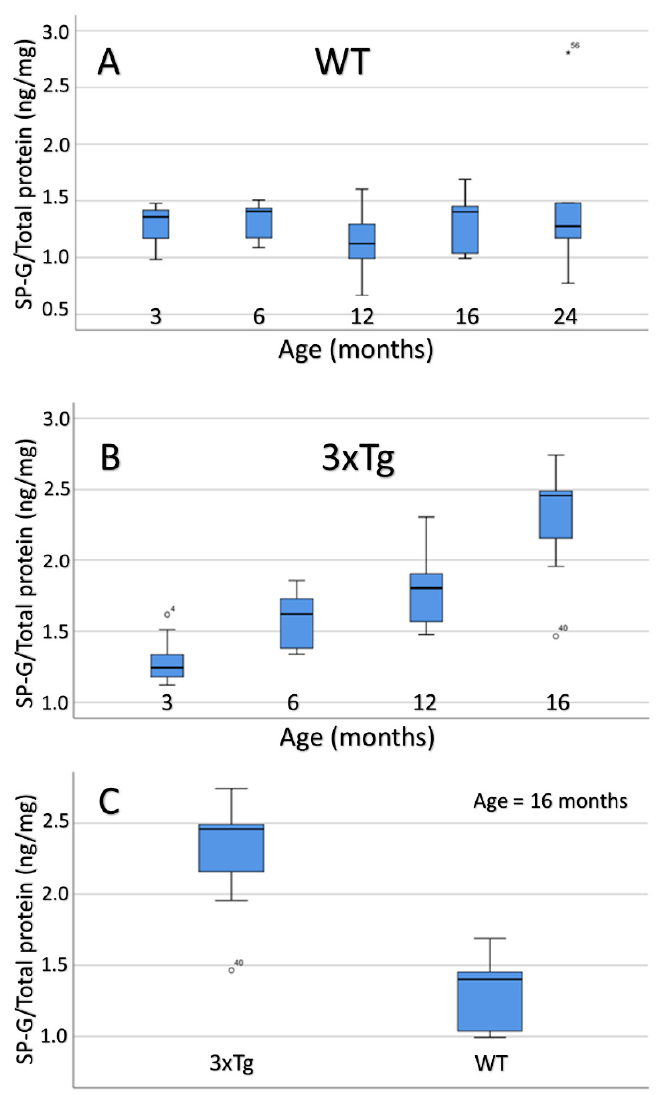
Figure 12. Box plot representation of the age-dependent SP-G content within the total intracellular brain protein fraction (specified in ng/mg). ( A ) WT mice: There are no statistically significant differences between the age groups. ( B ) In 3xTg mice, a clear increase of the SP-G content during aging becomes evident. The Tukey post-hoc analysis detected significant differences between all age groups except for the comparisons between 3 and 6 month-old animals ( p = 0.156) and 6 and 12 month-old mice ( p = 0.528). ( C ) Box plot representation of the SP-G content within the total intracellular protein fraction of 16 month-old mice brain depending on genotype (specified in ng/mg). ANOVA analysis revealed a significantly increased SP-G content in 3xTg mice when compared to their age-matched WT controls ( p = 0.001). ◦ : Indicates data values lying 1.5 to 3× of the IQR away from the mean value. *: Indicates data values lying >3× of the IQR away from the mean value. Comparing 3 month-old 3xTg mice with their age-matched controls showed no sig- The comparison of aging 3xTg-mice, however, shows a clear increase of intracellular nificant difference in intracellular SP-G content (ANOVA: p = 0.924). For the 6, 12, and 16 SP-G content (Figure 12B). The Tukey post-hoc analysis revealed a significant difference month-old animals, ANOVA analysis elucidated statistically significant greater contents between the 3 and 12 month-old 3xTg animals ( p = 0.005), as well as between the 3 and of intracellular SP-G in 3xTg mice than in age-matched WT mice (6 months: p = 0.023; 12 16 month-old mice ( p < 0.001). Furthermore, both 6 and 12 month-old animals showed a months: p = 0.003; 16 months: p = 0.001; Figure 12C). significantly lower intracellular SP-G content than the 16 month-old 3xTg-mice in the Tukey For the 3xTg mice, a strong and statistically significant positive correlation of age and post-hoc analysis (6 vs.16 months: p = 0.001; 12 vs. 16 months: p = 0.025). On the other hand, intracellular SP-G content could be determined (Spearman’s ρ = 0.831, p < 0.001; Figure no significant differences were observed between 3 and 6 month-old mice ( p = 0.156), as 13). This correlation could not be observed in the group of WT animals (Spearman’s ρ = well as between 6- and 12-month-old mice ( p = 0.036, p = 0.881).